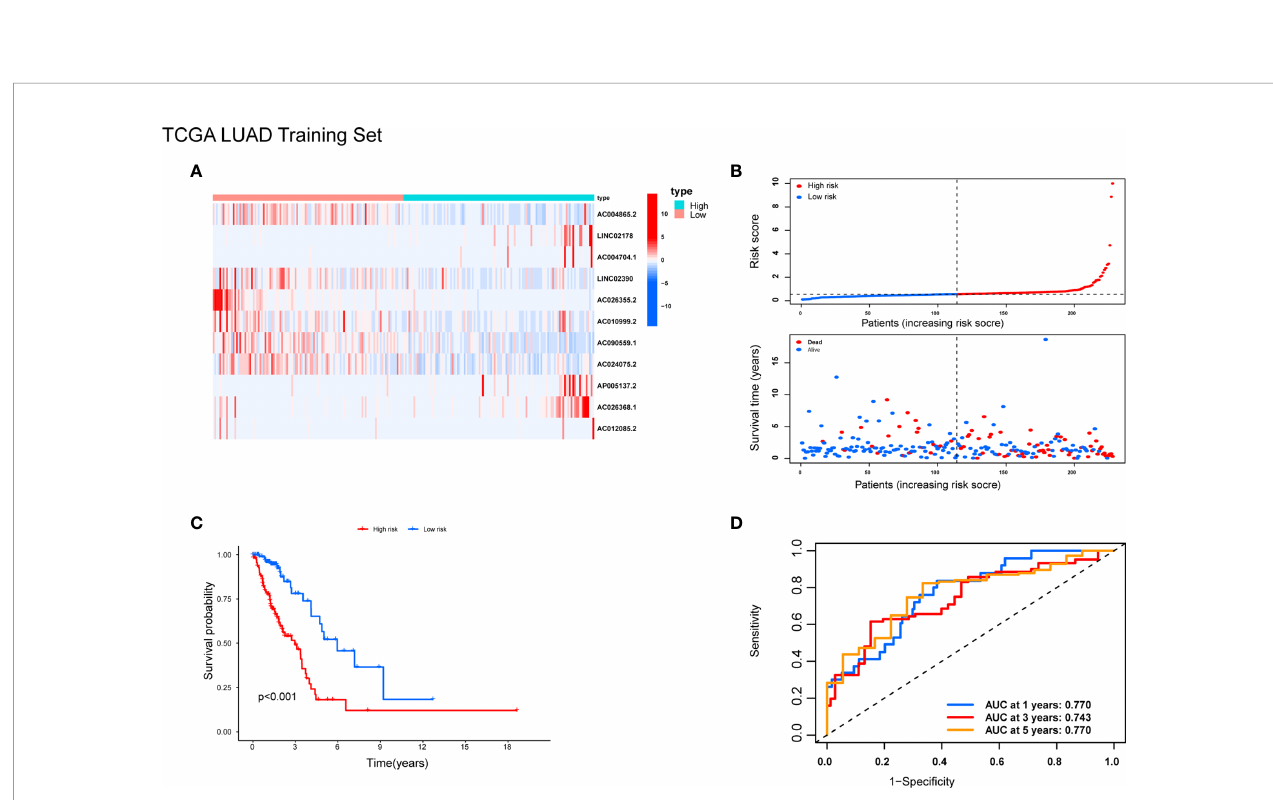
FIGURE 4 | Prognostic analysis of 11-lncRNAs model in the TCGA training cohort. (A) Heatmap of 11 pyroptosis-related lncRNAs in the training cohort. (B) Distribution of survival time and risk scores. (C) Survival analysis in the TCGA training cohort. (D) ROCs for 1, 3, and 5 year survival time based on the risk